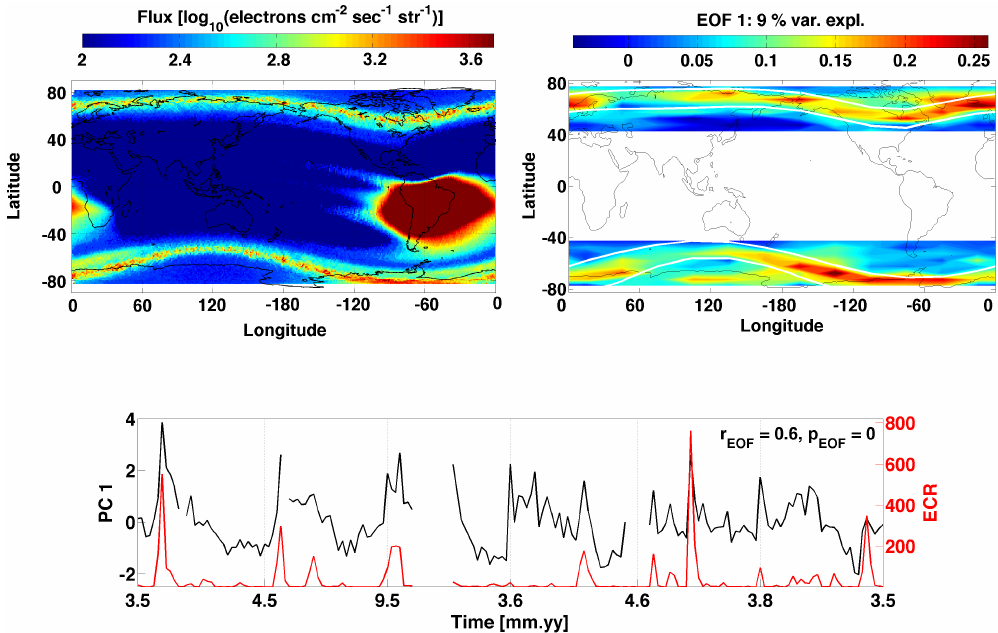
Fig. 8. Top left panel: World maps showing medians of > 30 keV precipitating electrons observed by the 0 ◦ directed MEPED telescopes onboard POES for 6 selected months (see description in the text). Top right panel: first EOF mode as a function of latitude and longitude for selected months between January 2005–December 2009. Numbers in percent indicate variance represented by each mode to the total variance. Bottom panel: the PC (black lines) of the first EOF mode. Red line represents the daily mean electron count rates. Approximate geomagnetic latitudes 55–72 ◦ N/S are indicated by superimposed white